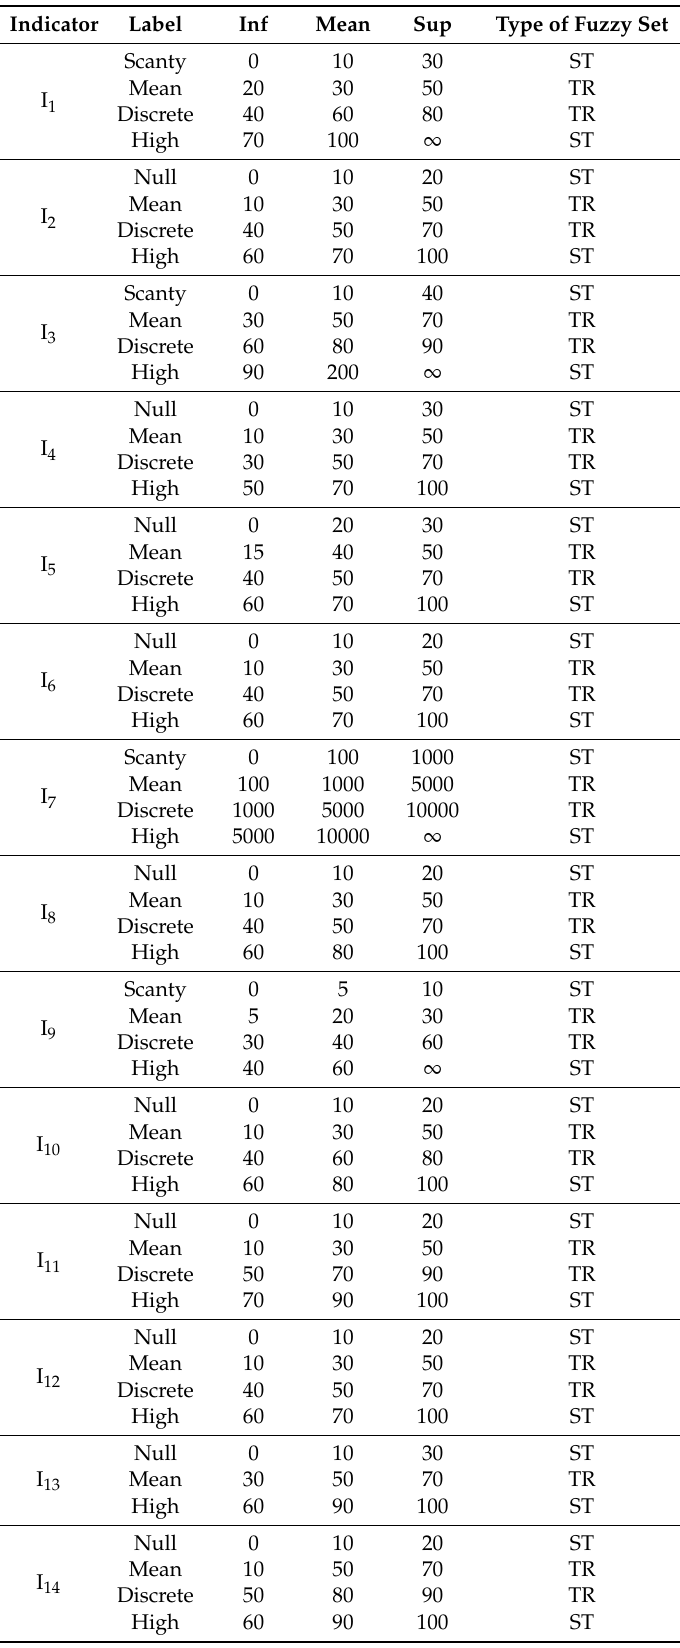
Table 2. Fuzzy partitions of the indicators (ST = Semi-Trapezoidal, TR = Triangular).